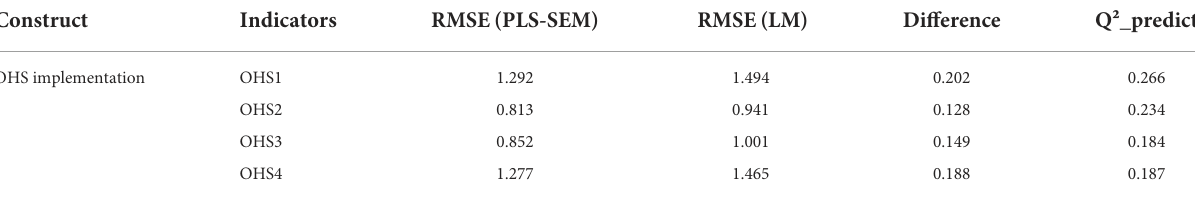
TABLE 6 Structural model: Pls